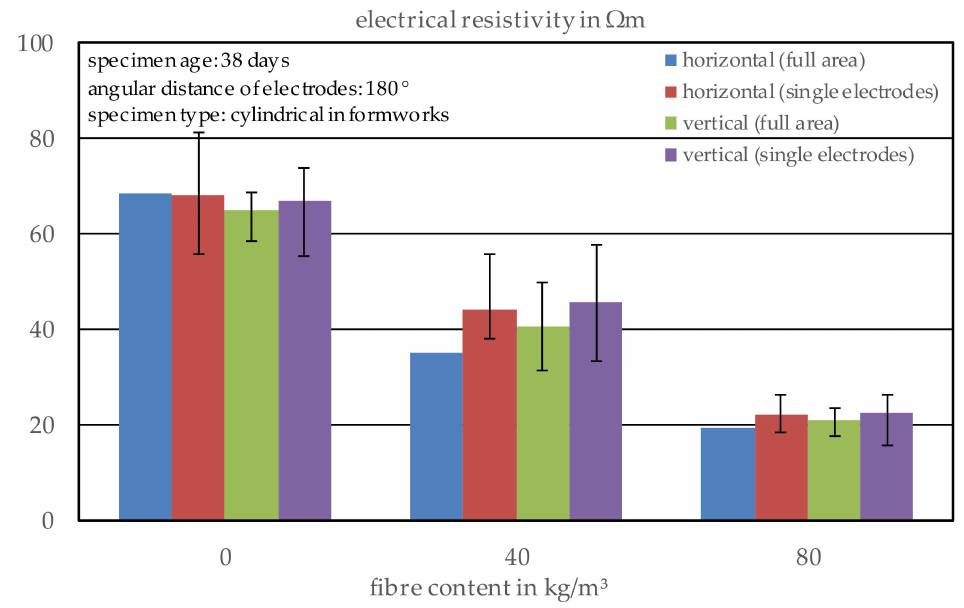
Figure 7. Electrical resistivity in different directions depending on fibre content at a specimen age of 38 days and an electrode array with angular distances of 180 ◦ .